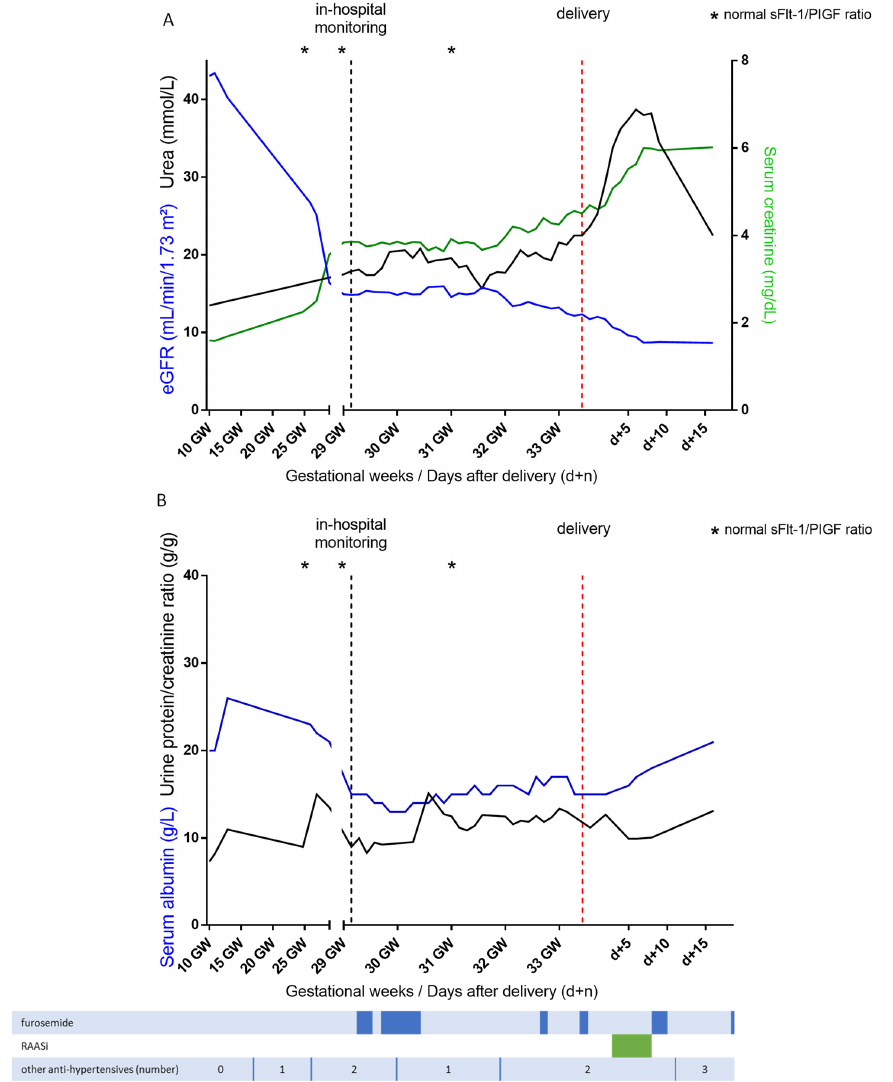
Figure 1. Evolution of the kidney function ( A ) assessed by serum creatinine (green line), estimated glomerular filtration rate (eGFR, blue line) and urea (black line) and nephrotic syndrome ( B ) assessed by urine protein/creatinine ratio (black line) and serum albumin (blue line) during pregnancy and after delivery. GW gestational weeks, RAASi Renin–angiotensin–aldosterone system inhibitor, sFlt-1/PIGF soluble fms-like tyrosine kinase 1-to-placental growth factor